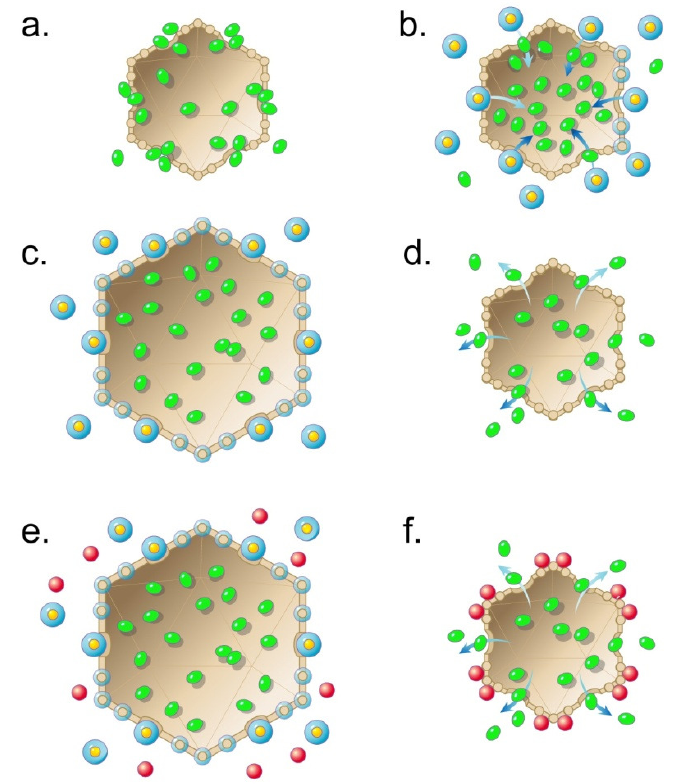
Figure 2. The first proposed abiotic ancestor and its transformations. Tan, abiotic shell- forming atom; yellow, high-energy compound; blue, water cage; green, organic molecules; red, product of reaction of the green organic